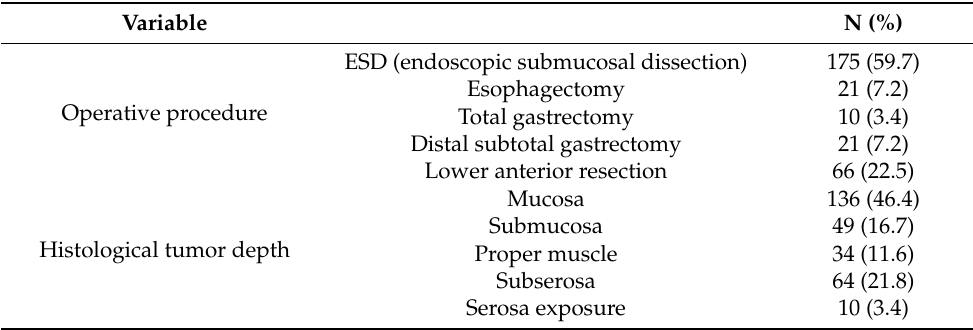
Table 3. Operative procedure and pathological findings (N =